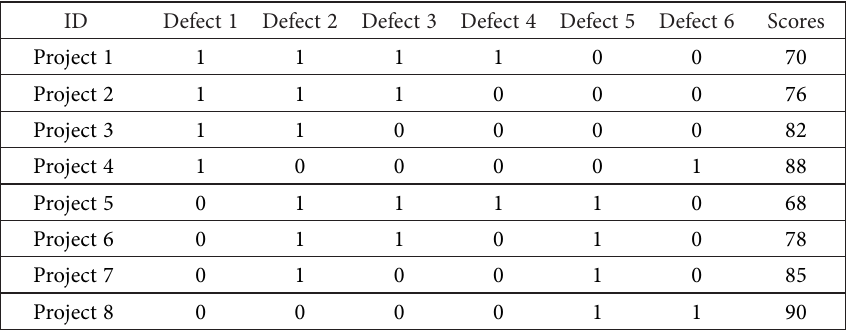
Table 3. Defect statistics (for